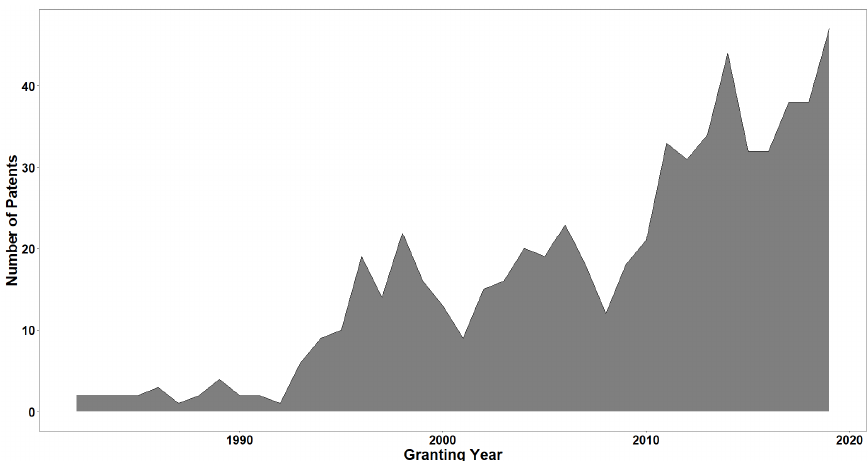
Figure 3. Distribution of DOSD patents granting year.